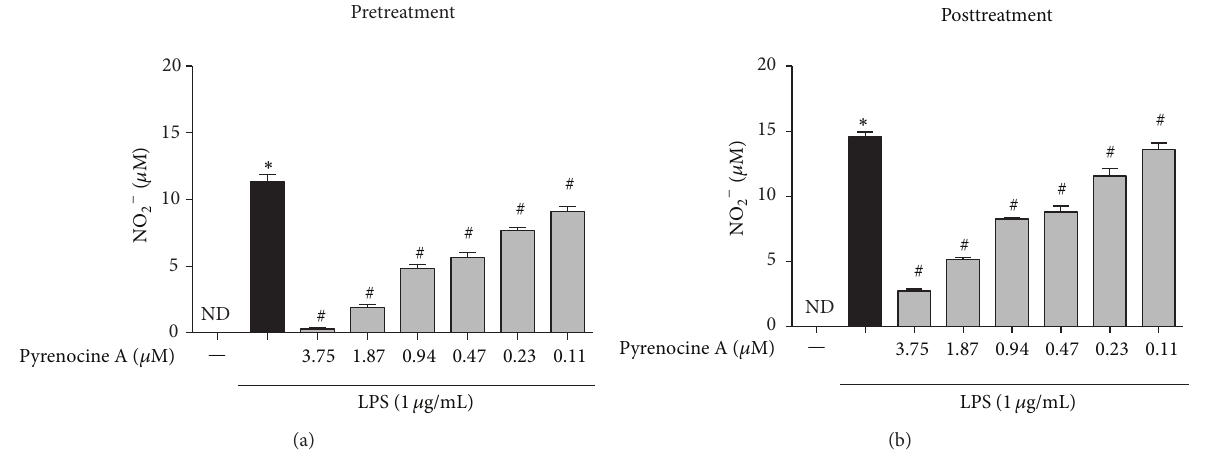
Figure 2: Anti-inflammatory effects of pyrenocine A on the production of NO. Pretreatment procedure: cells were pretreated with different concentrations of pyrenocine A (3.75–0.11 𝜇 M) for 2 h and then stimulated with LPS (1 𝜇 g/mL) during 18 h. Posttreatment procedure: cells were stimulated with LPS (1 𝜇 g/mL) for 2 h and then pyrenocine A was added (3.75–0.11 𝜇 M) during 18h. Afterwards, the supernatants were collected, and nitrite concentrations were determined using Griess reagent. Results indicate the mean ± SEM for six independent experiments performed in quadruplicate for each condition. ∗ 𝑃 < 0.05 versus medium (control), # 𝑃 < 0.05 versus LPS (ANOVA followed by Bonferroni). ND = not detectable.